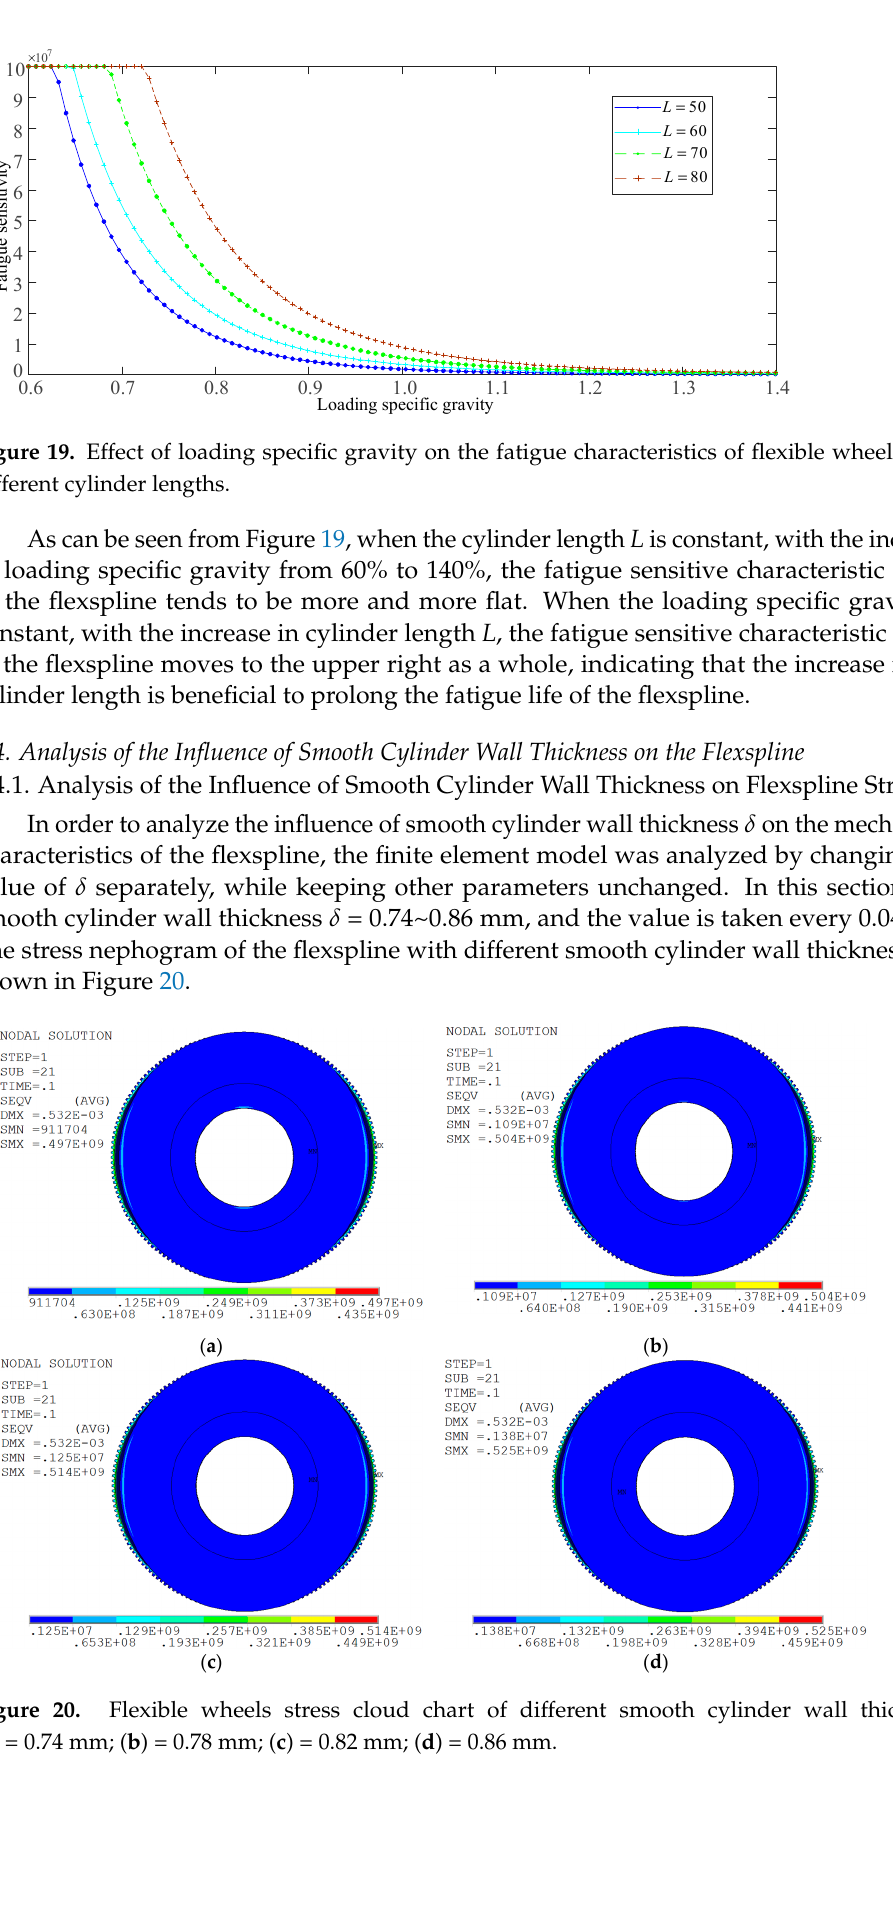
( d ) Figure 18. Stress influence curve of different round length flexible wheels. ( a ) Stress variation curve of flexspline; ( b ) Stress change curve of the ring gear; ( c ) Cylinder stress change curve; ( d ) Bottom stress variation curve.